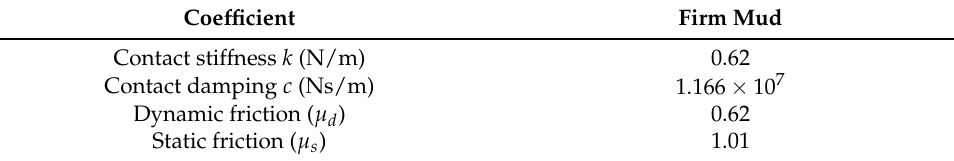
Table 2. Contact force parameters for two seabed